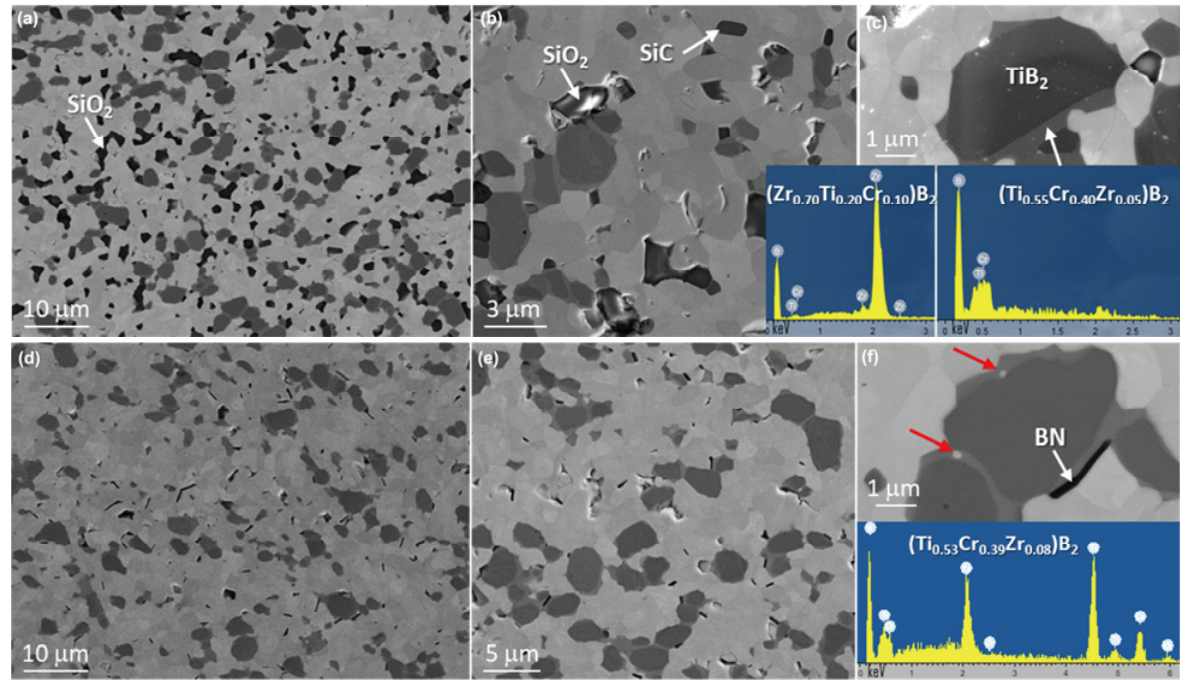
Fig. 5 Representative SEM images of the sintered (a–c) ZTC-A and (d–f) ZTC-B ceramics with corresponding EDS spectra. Red arrows in (f) highlight particles trapped at the TiB 2 core–shell